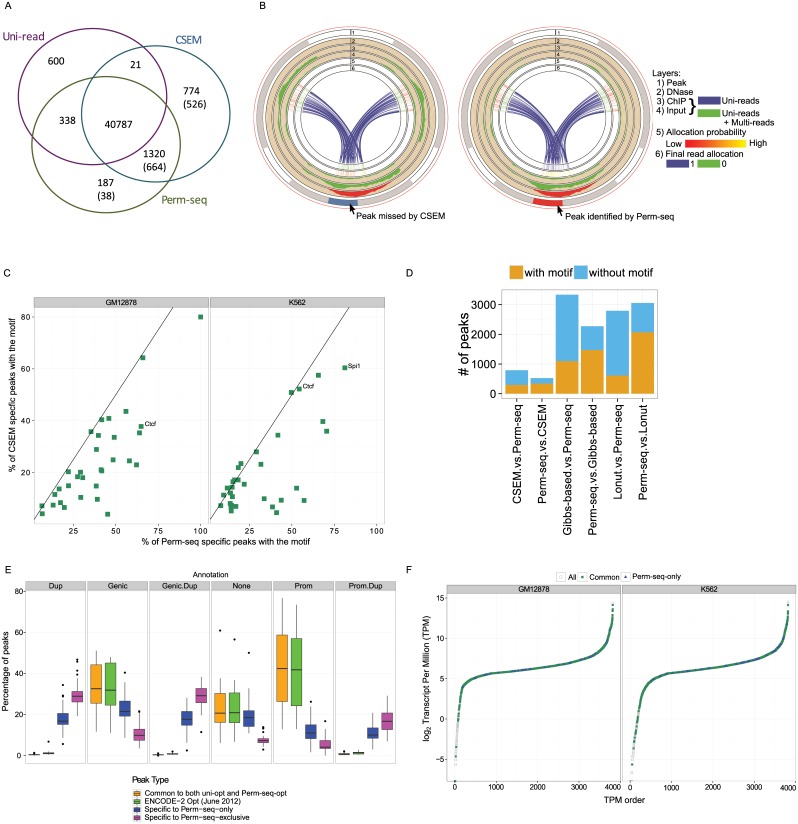
Comparison of uni-read, CSEM, and Perm-seq analysis.(a) Comparison of Ctcf optimal peak lists from uni-read, CSEM, and Perm-seq analyses. Numbers in parentheses denote comparisons of the optimal peak lists with the relaxed peak lists. For example, there are 1320 peaks identified by the Perm-seq and CSEM analyses and missed by the uni-read analyses. 664 of these peaks are still missed by the uni-read analysis even if we consider comparison of the Perm-seq and CSEM optimal peak lists with the uni-read relaxed lists. (b) Circos plots of CSEM (left) and Perm-seq (right) read allocation for reads mapping to four segmental duplication regions with coordinates chr1:143,880,003–143,978,943, chr1:206,072,707–206,171,611, and chr1:143,880,003–144,005,301, chr1:120,872,119–249,250,621. (c) Percentages of Perm-seq specific and CSEM specific peaks with the most significant motifs identified from the de novo sequence analysis of the intersection peaks, i.e., peaks common to uni-read, CSEM, and Perm-seq analysis. (d) Comparison of the Ctcf peak sets from GM12878 between Perm-seq, CSEM, Gibbs-based [2], and Lonut [4]. x.vs.Perm-seq denotes optimal peaks of method “x” not identified by Perm-seq. Similarly, Perm-seq.vs.x denotes optimal peaks of Perm-seq not identified by method “x”. (e) Annotation of the K562 peaks with respect to segmental duplications. Categories are: Prom.Dup: peaks that are in promoter regions (± 2500 bps of TSS) of RefSeq genes that reside in segmental duplications; Prom: Peaks in promoter regions (excludes peaks in Prom.Dup); Genic.Dup: peaks that are within [-10000 bps of TSS, +1000 bps of TES] of RefSeq genes that are in segmental duplications (excludes peaks in Prom.Dup); Genic: peaks that are within [-10000 bps of TSS, +1000 bps of TES] of RefSeq genes (excludes peaks in Genic.Dup, Prom.Dup); Dup: peaks that are in segmental duplications (excludes Prom.Dup and Genic.Dup); None: peaks that do not fall into any of the other defined categories. (f) Genes are ordered with respect to RNA-seq transcripts per million (TPM) values. Genes with a Common Pol2 peak in their promoters are depicted with green whereas genes with only Perm-seq-only peaks are depicted in blue.